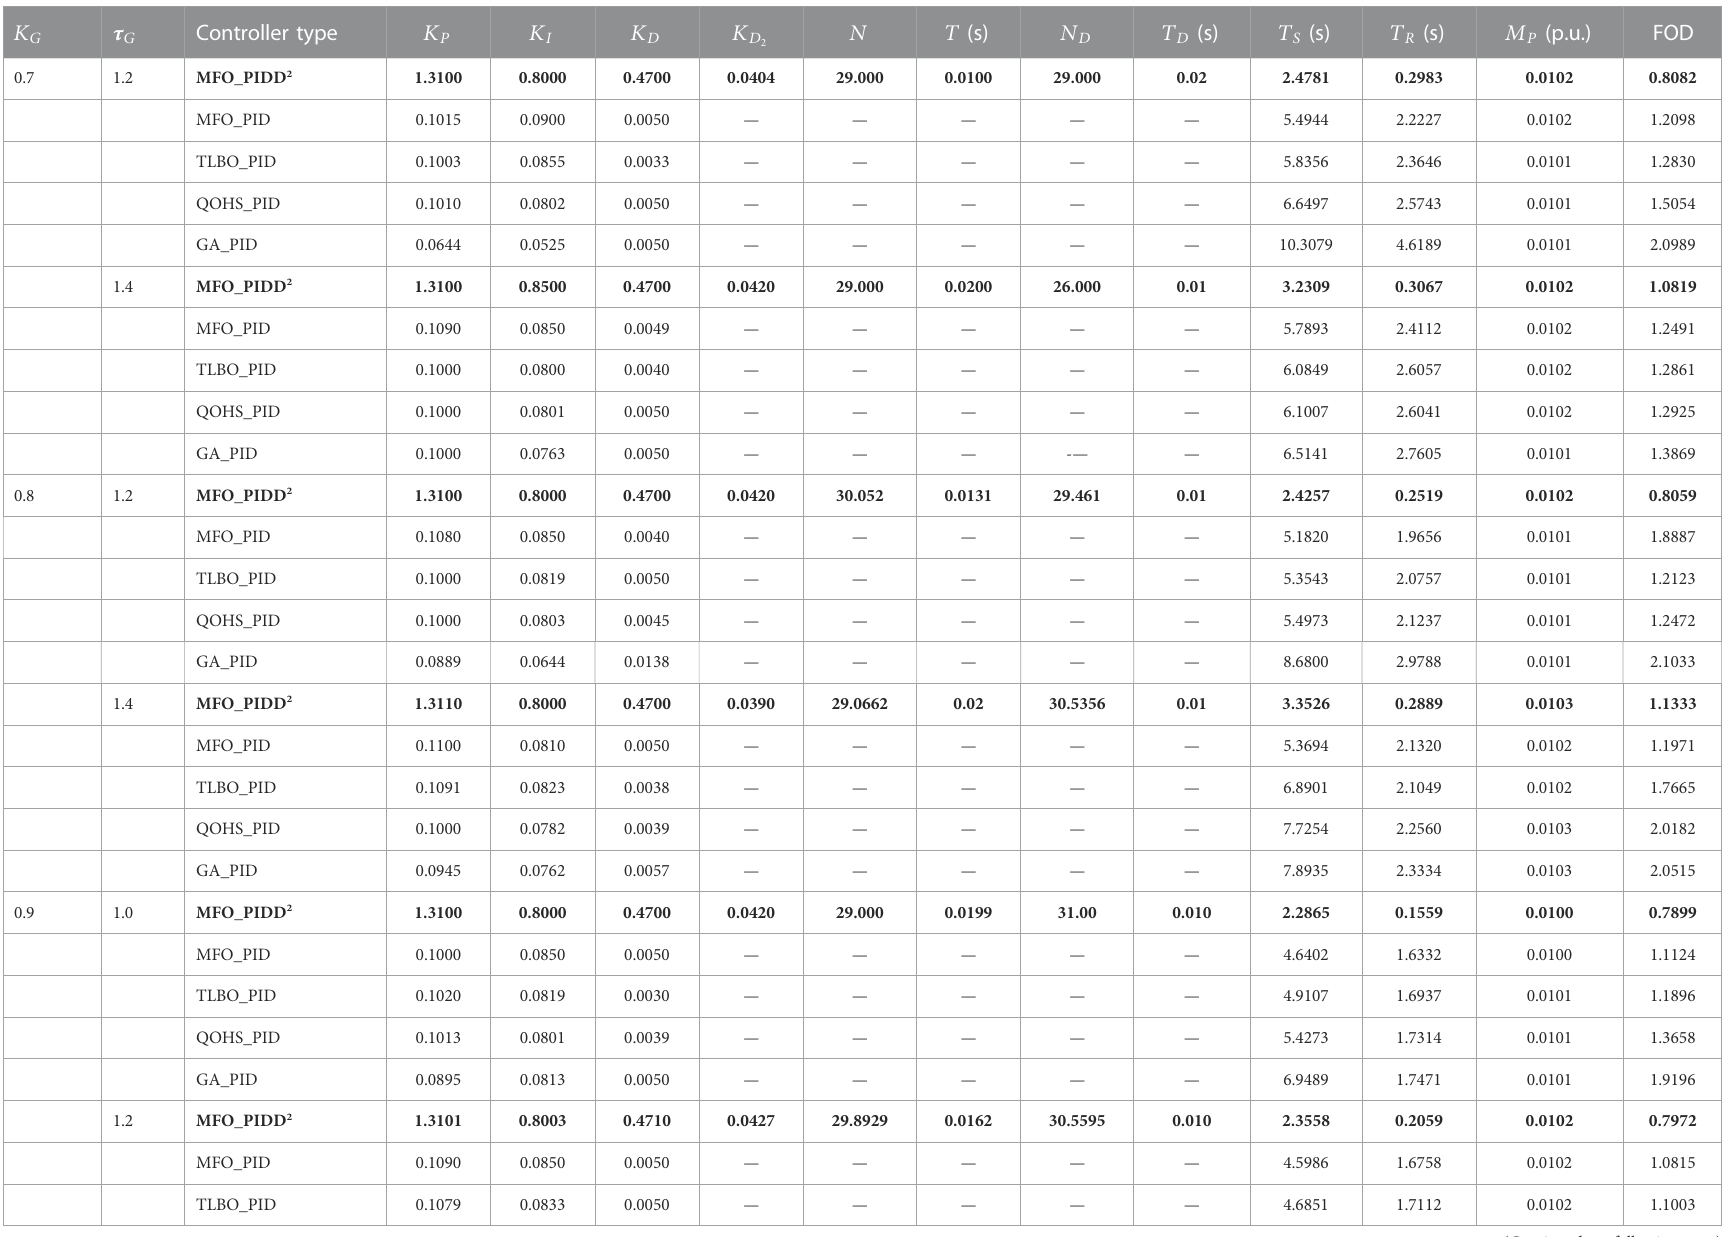
TABLE 2 MFO-optimized controller gains and transient response parameters with varying K G and τ G . K G τ G 0.7